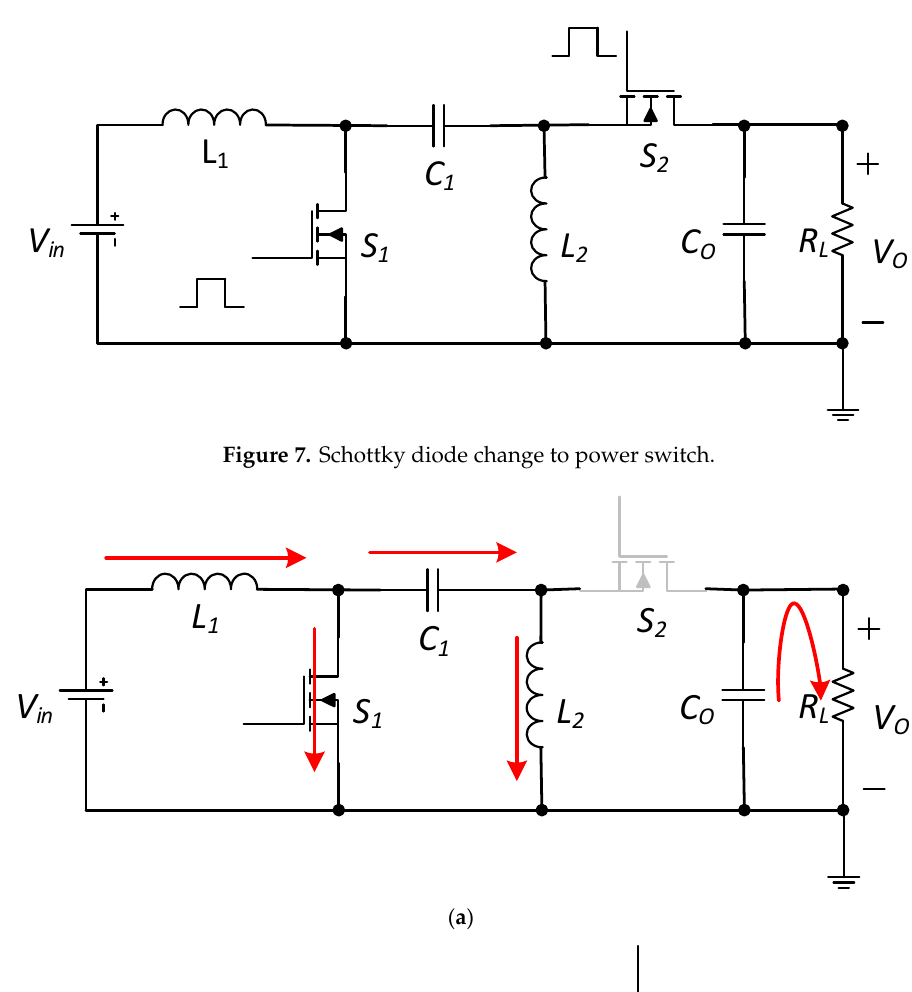
Figure 8. Circuit operation: ( a ) S 1 is on, S 2 is off; ( b ) S 1 is off, S 2 is on.